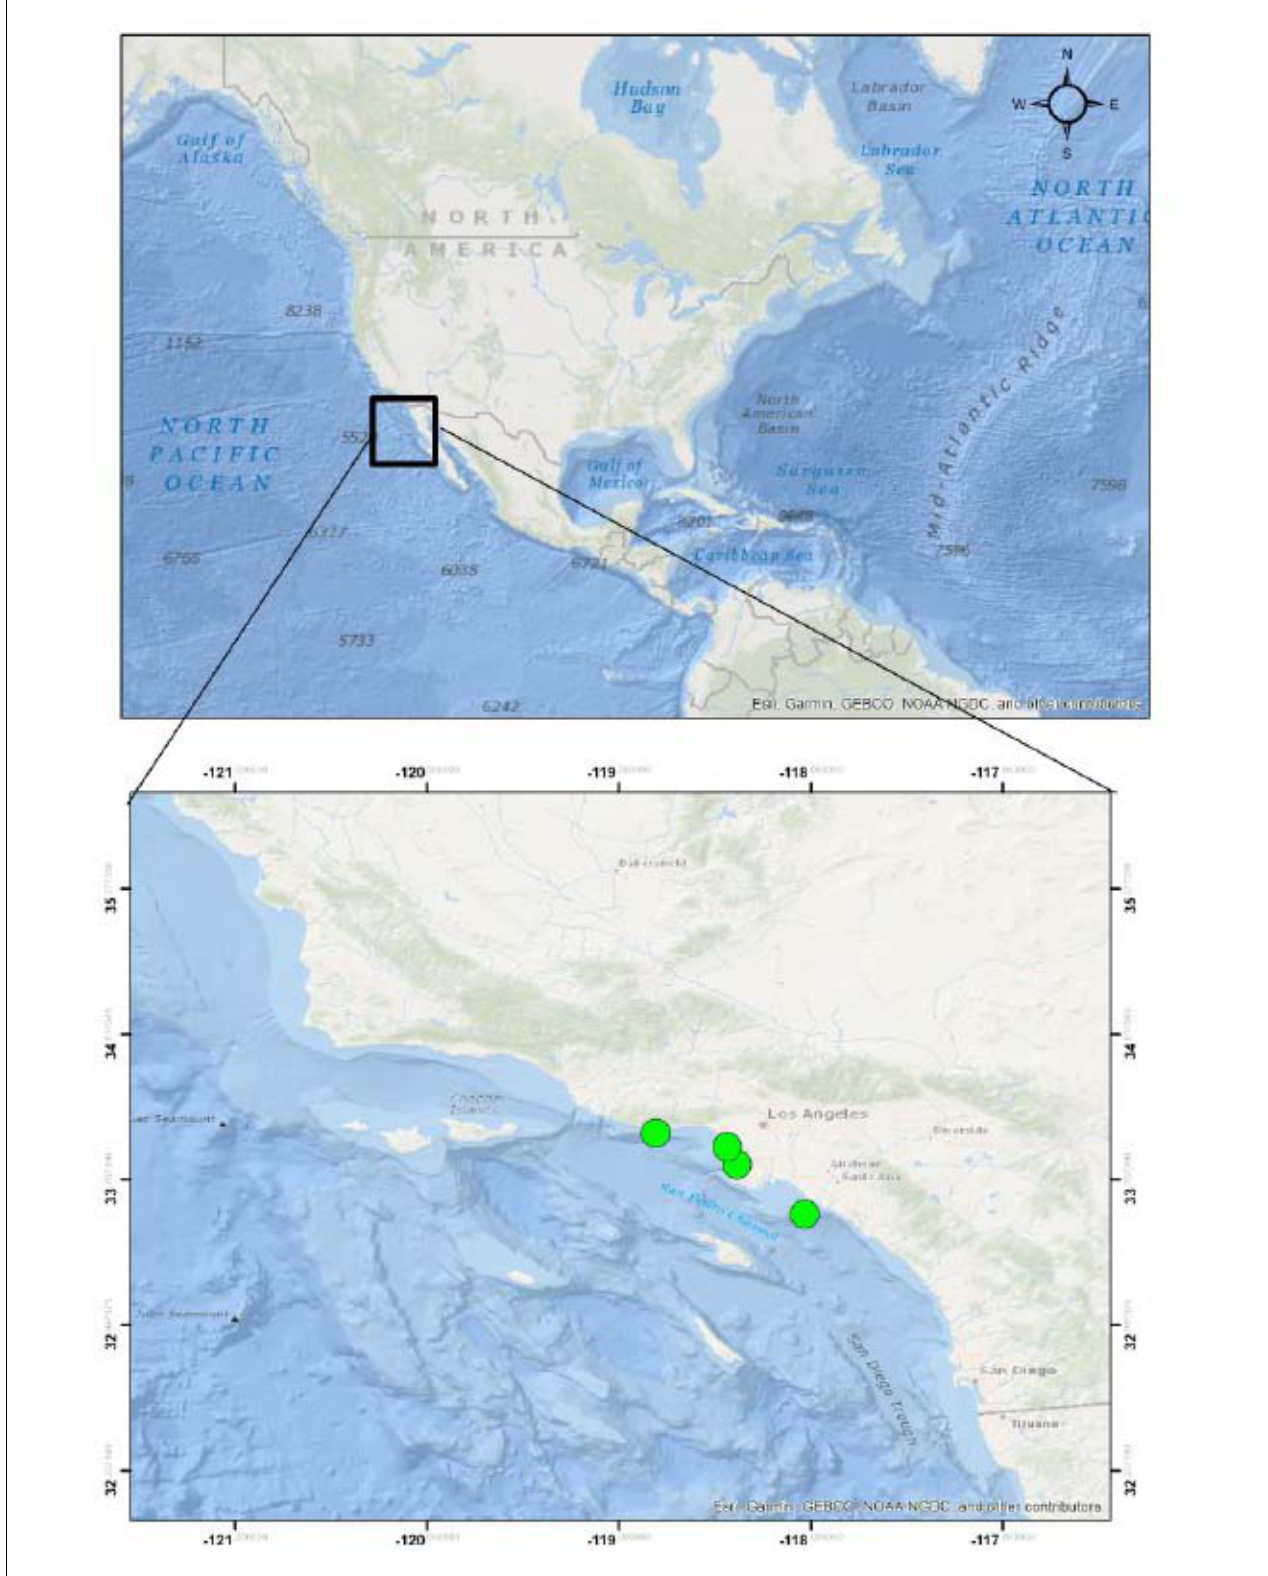
FIGURE 1 | Stranding localities of the California sea lions ( Zalophus californianus ) acquired for this study.